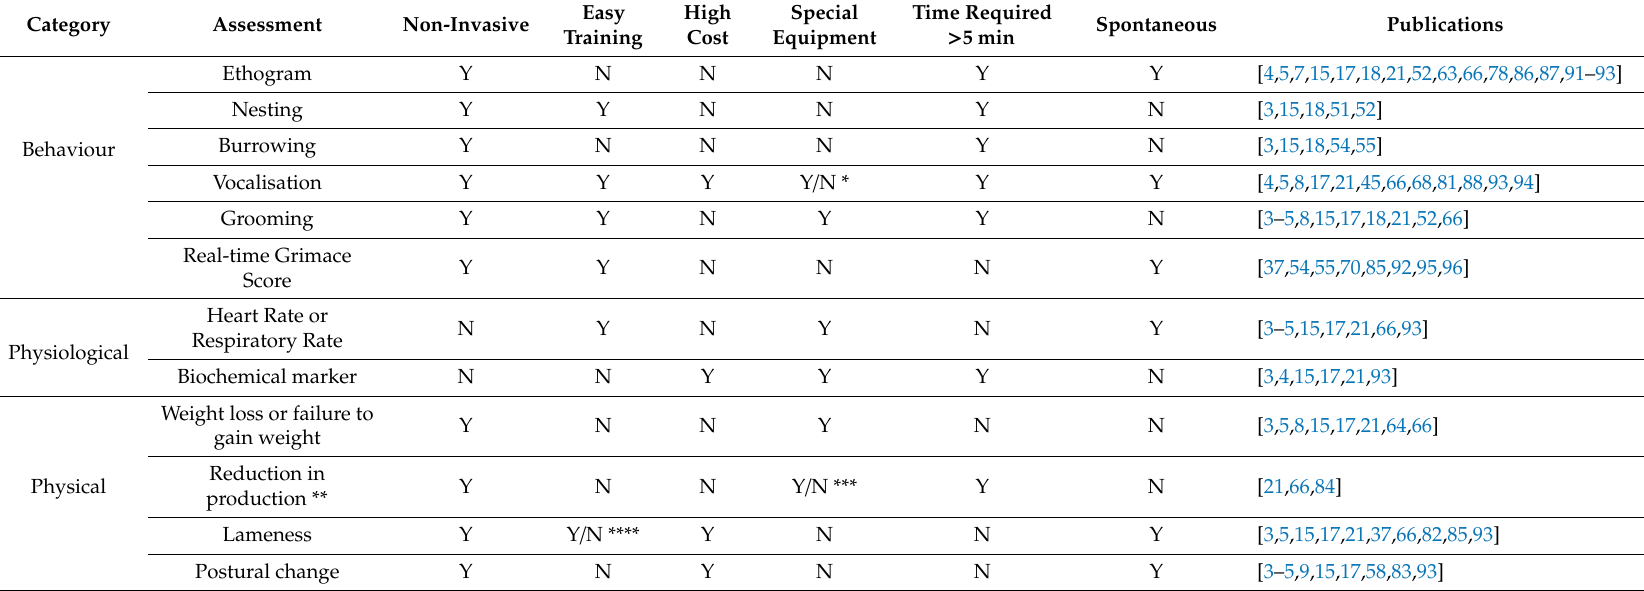
Table 1. Behavioural, physiological, and physical pain assessment